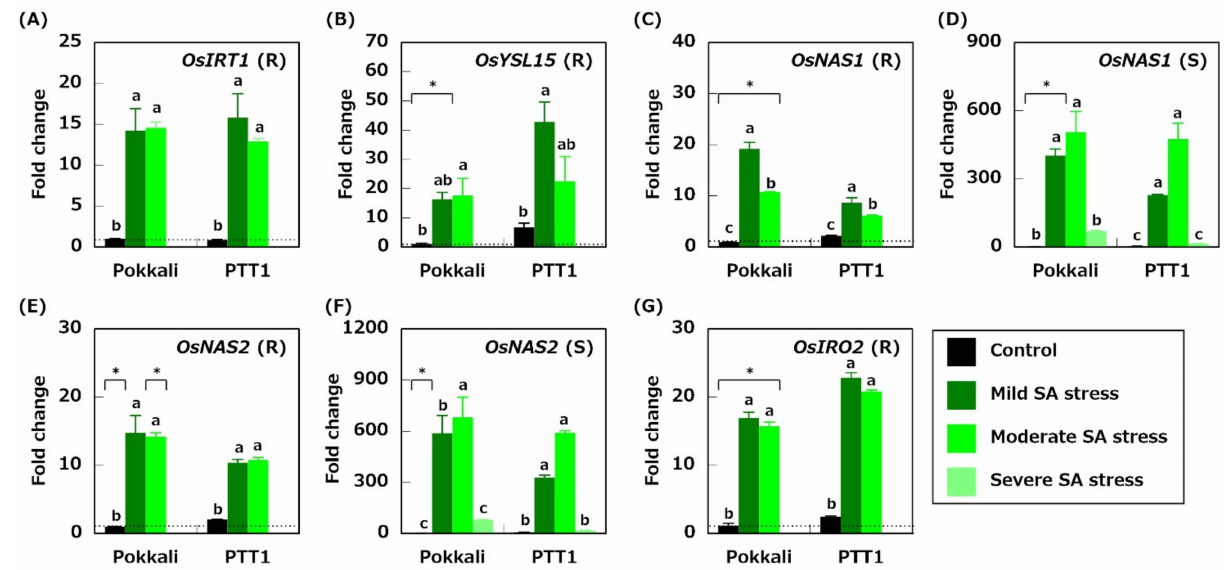
Figure 6. Relative expression of Fe acquisition-related genes; OsIRT1 (Fe (II) ion transporter) in the roots ( A ), OsYSL15 (Fe 3+ -DMA transporter) in the roots ( B ), OsNAS1 (nicotianamine synthases 1) in the roots ( C ) and shoots ( D ), NAS2 (nicotianamine synthases 2) in the roots ( E ) and shoots ( F ) and OsIRO2 (transcription factor) in the roots ( G ) of Pokkali and PTT1. The number of gene transcripts is evaluated based on that of Pokkali under control conditions. The concentration of each element in the roots of both rice varieties under severe SA conditions is not determined because of divalent metals deposition on the root surface. Data are the means of 3 replicates ± S.E. Similar letters indicate no significant differences between the treatments in each variety ( p < 0.05). Asterisks show significant differences between Pokkali and PTT1 in each treatment ( p <